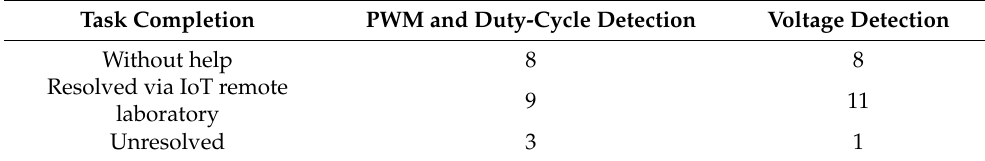
Table 4. Solving the task of detecting PWM signal and voltage from IoT monitoring device.